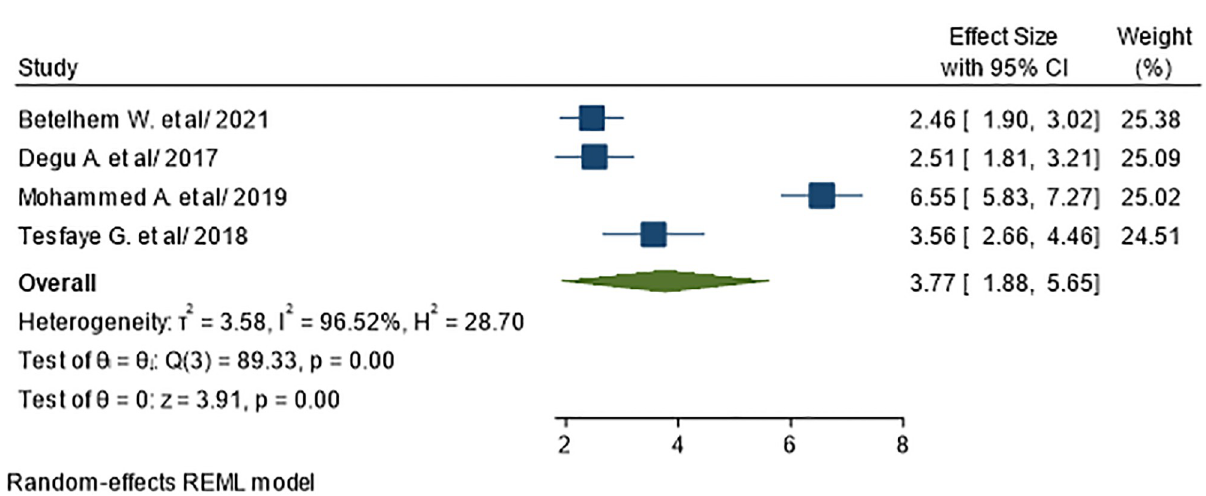
Fig 9. Association between female sex and UTI in diabetic patients.